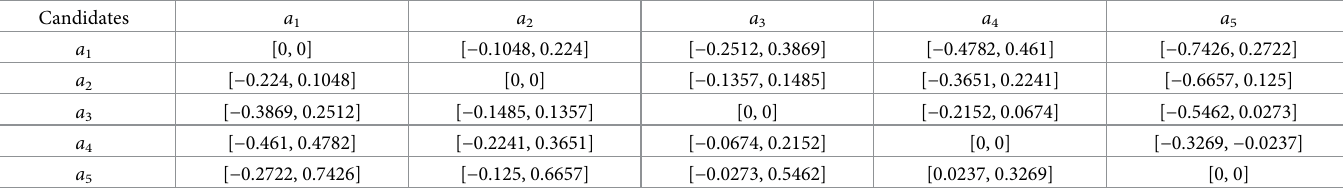
Table 3. Score intervals of the IDPRs between any two candidates in the manager selection problem.